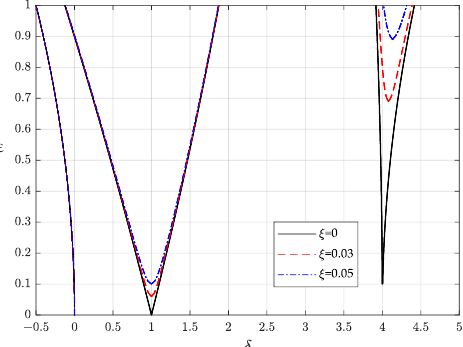
.. . x + 2 ξ x + ( δ + 2 ε cos2 t ) x + KD P [ x ] = 0.